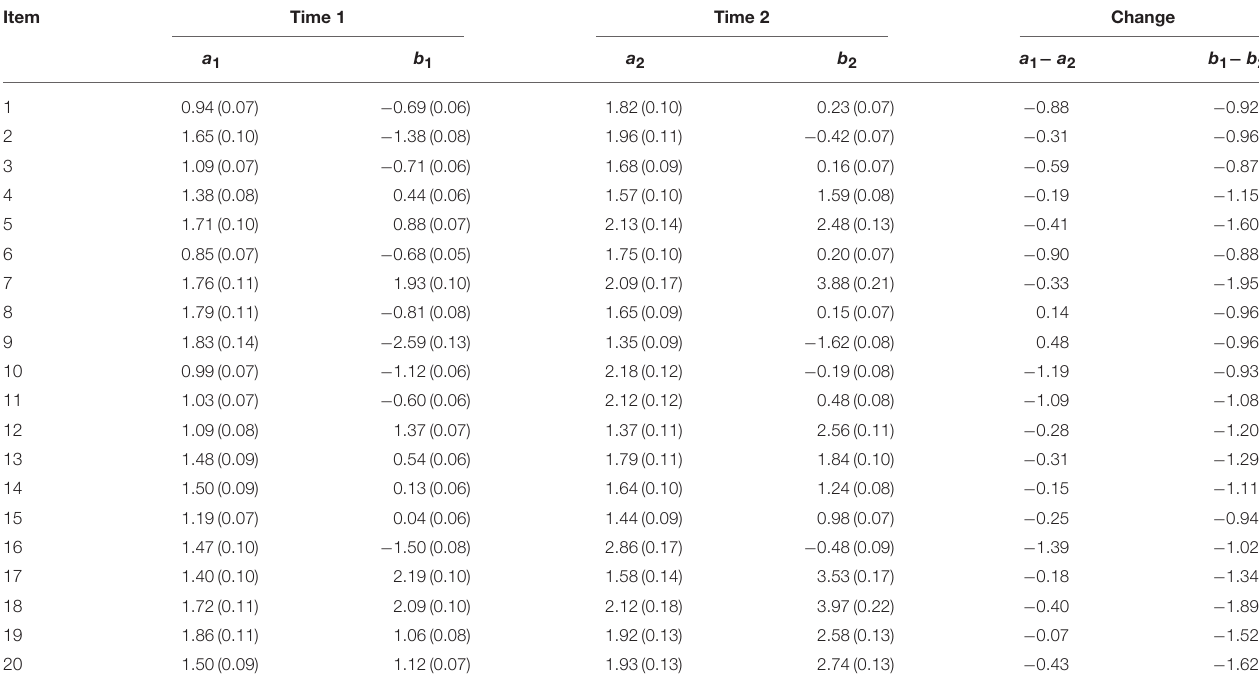
TABLE 8 | Fitting data generated from mixture IRT to unidimensional 2PL IRT model: Condition 3 (Increase in both item difficulty and discrimination for Group 1 at Time 2).